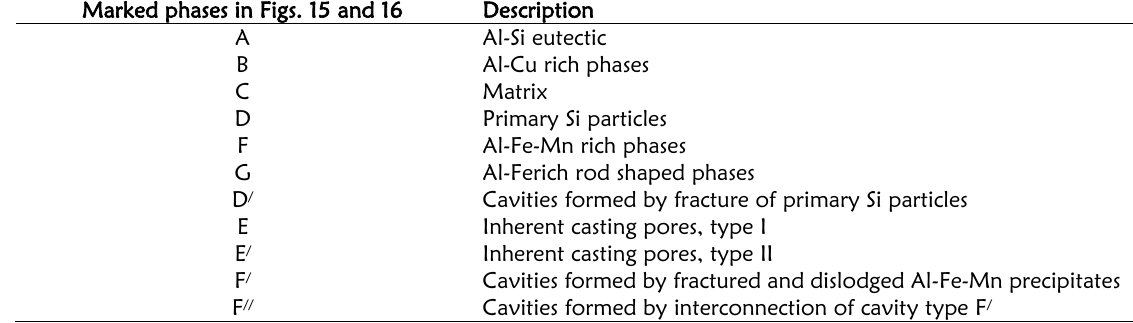
Table 1: List for various phases and cavities